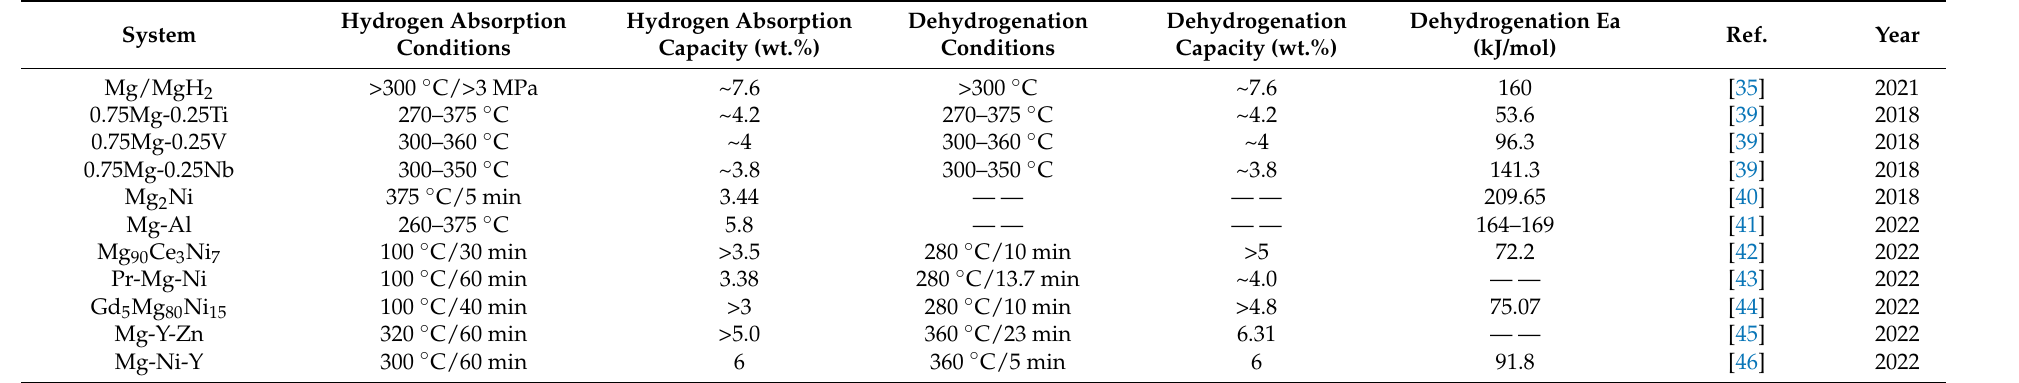
Table 1. Improvement of hydrogen storage performance of Mg/MgH 2 by alloying